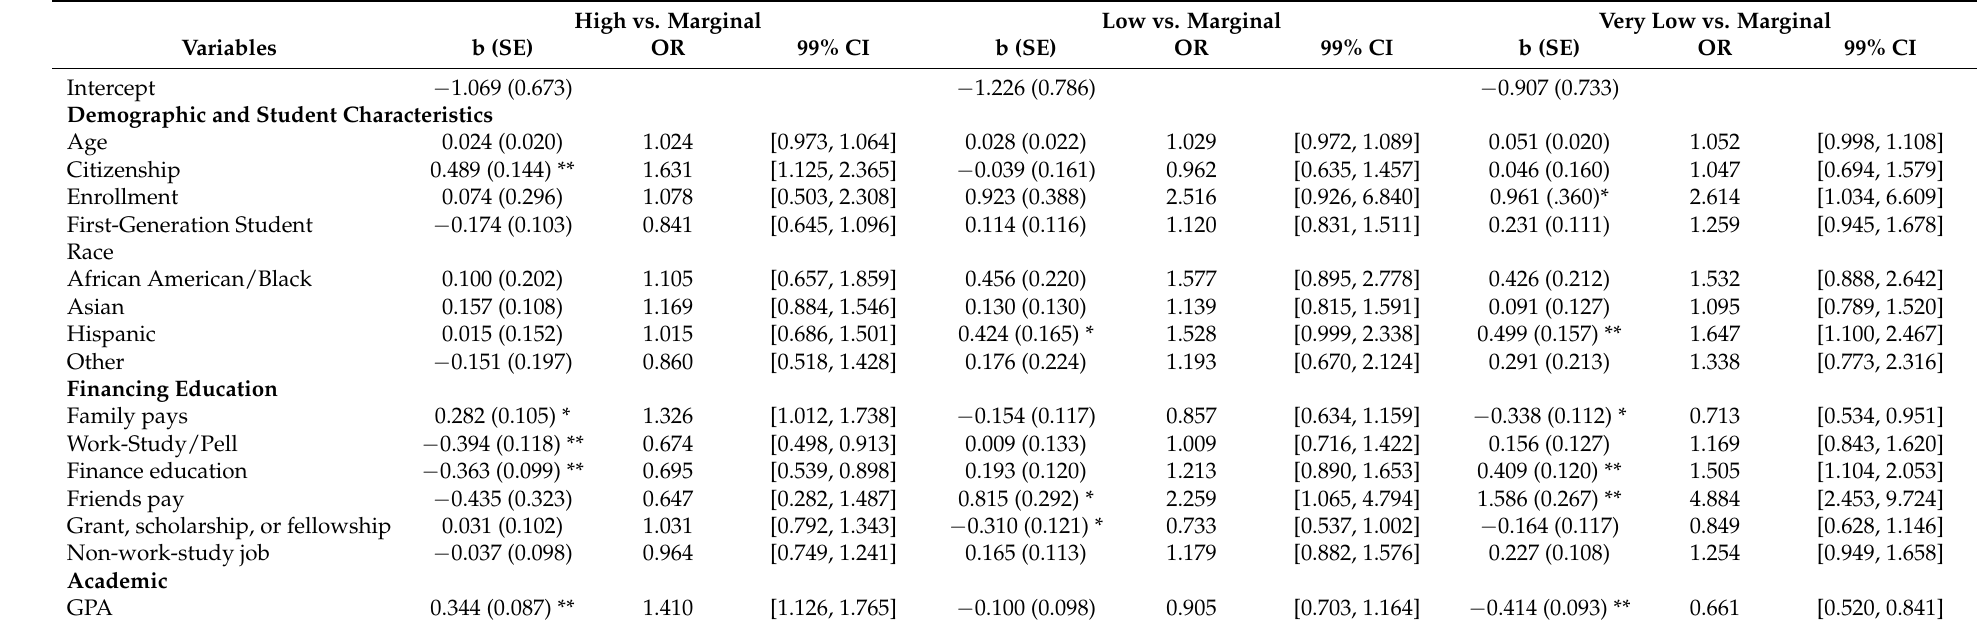
Table 4. Results of pairwise comparisons of the multinomial logistic regression. High vs. Marginal Low vs. Marginal Very Low vs.